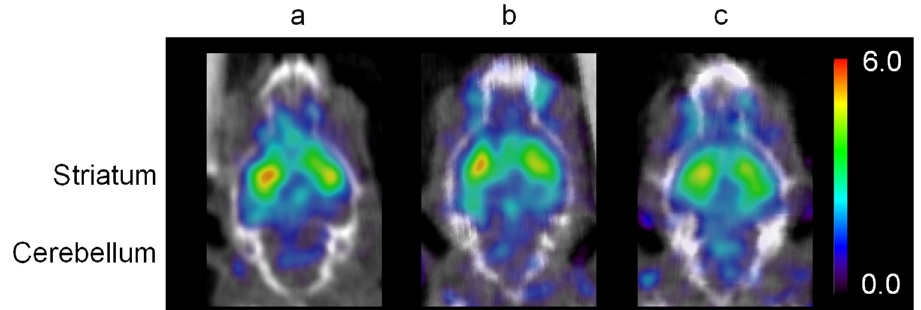
Figure 3. Representative [ 123 I]IBZM SPECT images of the control group, ( a ) intravenous domperidone administration (IV group), ( b ) intranasal domperidone administration (IN group), and ( c ) at 25–30 min after intravenous administration of approximately 14 MBq [ 123 I]IBZM. There is avid accumulation in the striatum in the control. Accumulation in the striatum is not much lower in the IV group with domperidone compared to the control, but clearly lower in the IN group with domperidone. There is little difference in accumulation in the cerebellum among the control, IV, and IN groups.